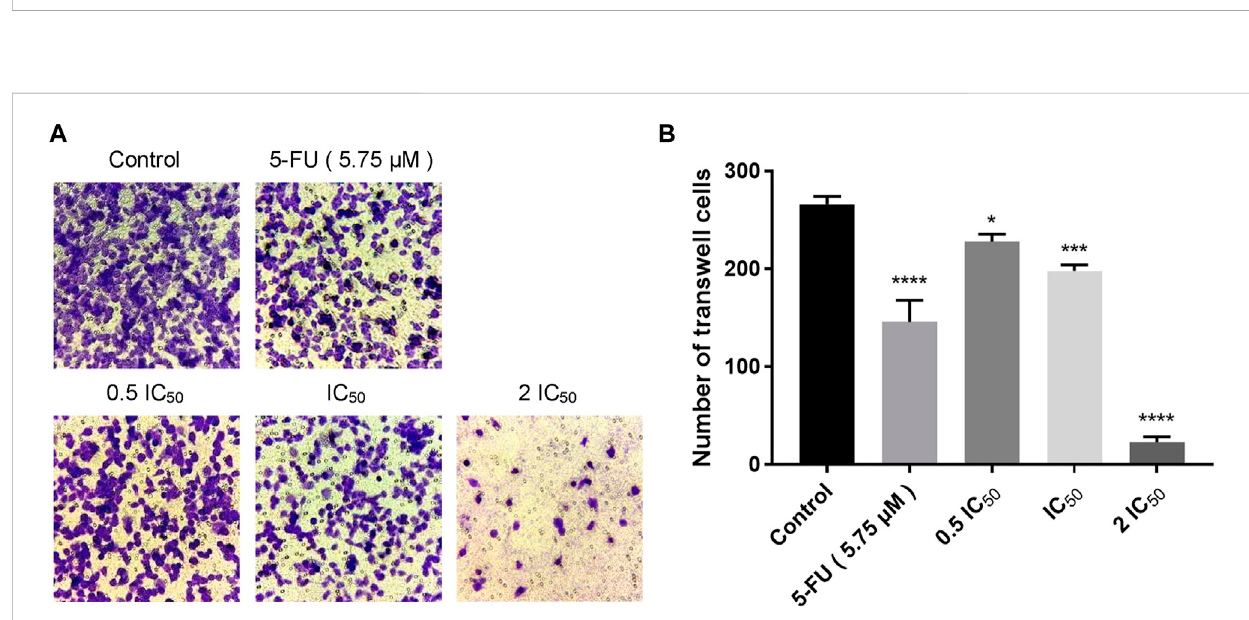
FIGURE 3 Compound 6e inhibited space migration of KB cells. (A) Microscopic images of spatial migration of KB cells treated with compound 6e . (B) Quanti fi cation of the cell space migration results ( n > 3). **** ( p < 0.0001), *** ( p < 0.001), ** ( p < 0.01), * ( p < 0.05), ns (not signi fi cant).